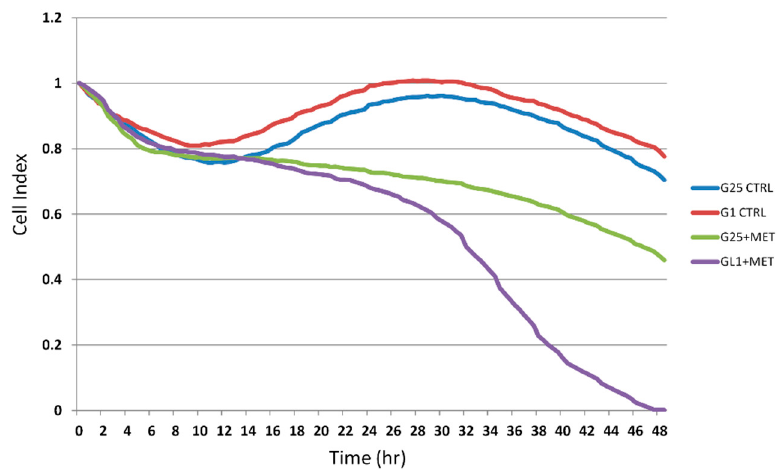
Figure 2. Metformin decrease cell proliferation in presence of different glucose concentrations. DU145 proliferation in the different groups recorded in real time, using the xCELLigence system. The cells showed growth with 1 mM glucose (G1) or 25 mM glucose (G25) in presence and absence of 10 mM metformin (MET).